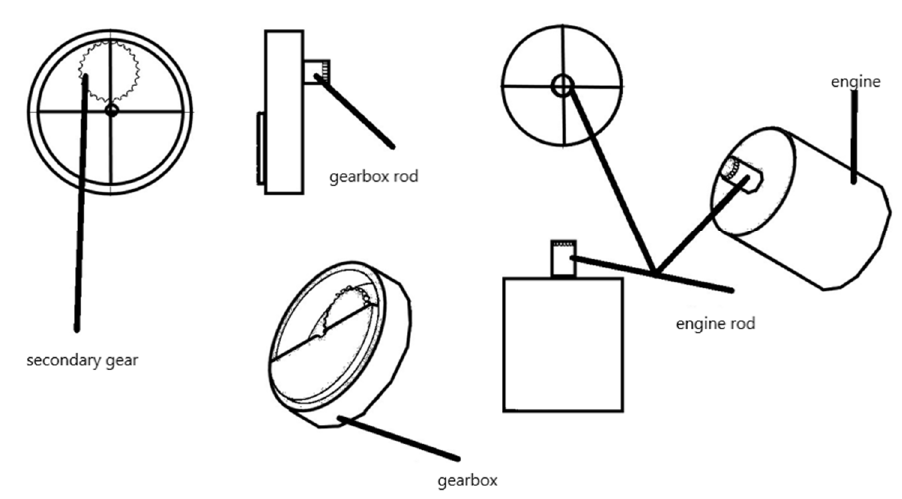
Figure 5. Views of the motor and transmission.